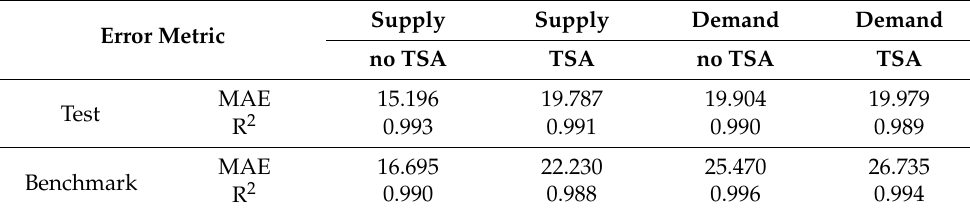
Table 1. Error metrics for supply and demand models based on test and benchmark-data. Supply Supply Error Metric